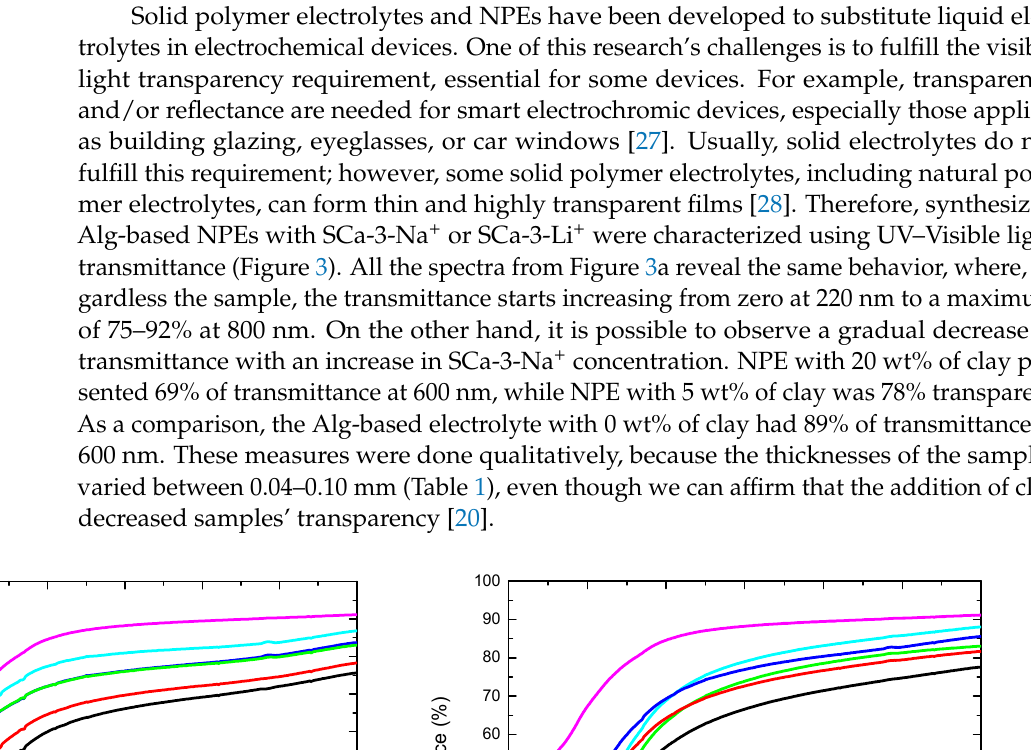
( b ) Figure 4. Reflectance spectra for Alg-based NPEs with 0–20 wt% of ( a ) SCa-3-Na + and ( b ) SCa-3-Li + . Beyond transparency, electrical conductivity is essential for successful electrolyte use. Lu et al. [18] and Leones et al. [17] have claimed that electrolytes should satisfy re- quirements, such as environmental stability, electrochemical window over 1 V, low vola-